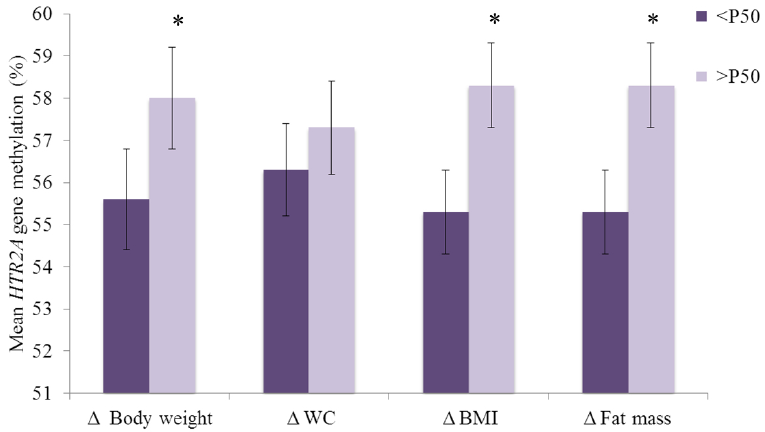
Figure 3. Association of baseline mean HTR2A gene methylation (%) with changes (six-month baseline) in anthropometric and body composition measurements divided by their medians in the whole-study sample n = 34. Δ = six-month baseline. Data are expressed as mean (CI 95%). Abbreviations: BMI, body mass index; WC, waist circumference. <P50 = high responders; >P50 = low responders to the dietary treatment. * p <